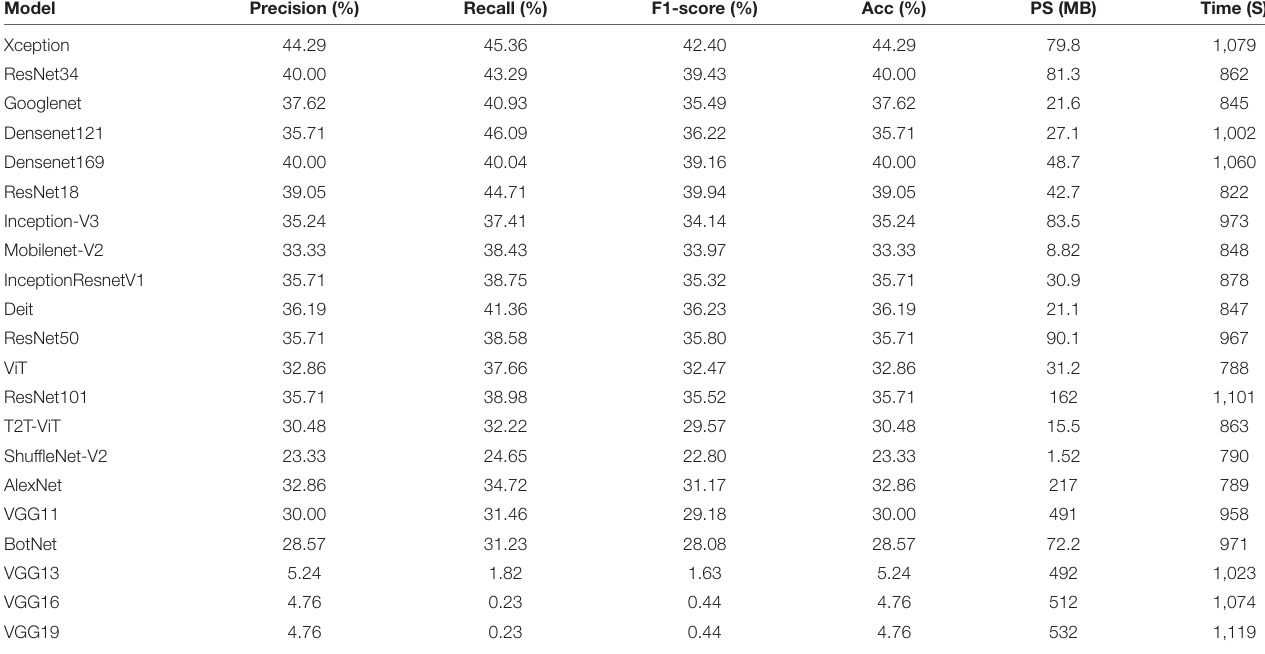
TABLE 11 | Classification results of different deep learning models.